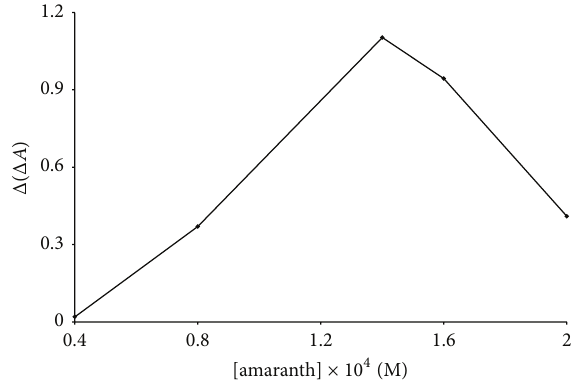
Figure 4: Effect of amaranth concentration on the sensitivity. Conditions: H 2 SO 4 , 2.4 M; SCG; 12ng mL −1 ; TBAB, 1.1 × 10 −3 M; IO 4− 4.0 × 10 −4 M; temperature, 25 ∘ C.